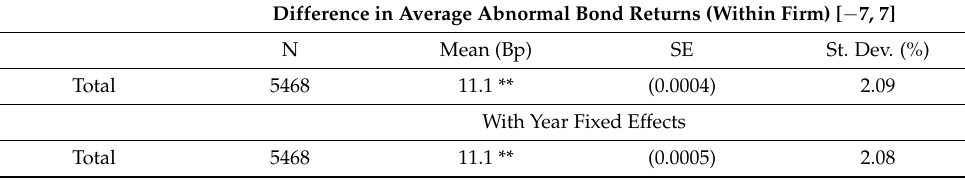
Table 8. Within Firm Individual Issue